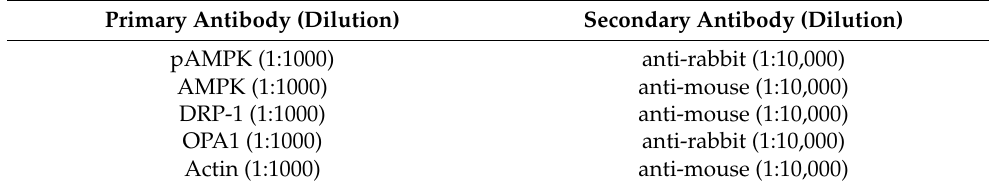
Table 2. Antibodies